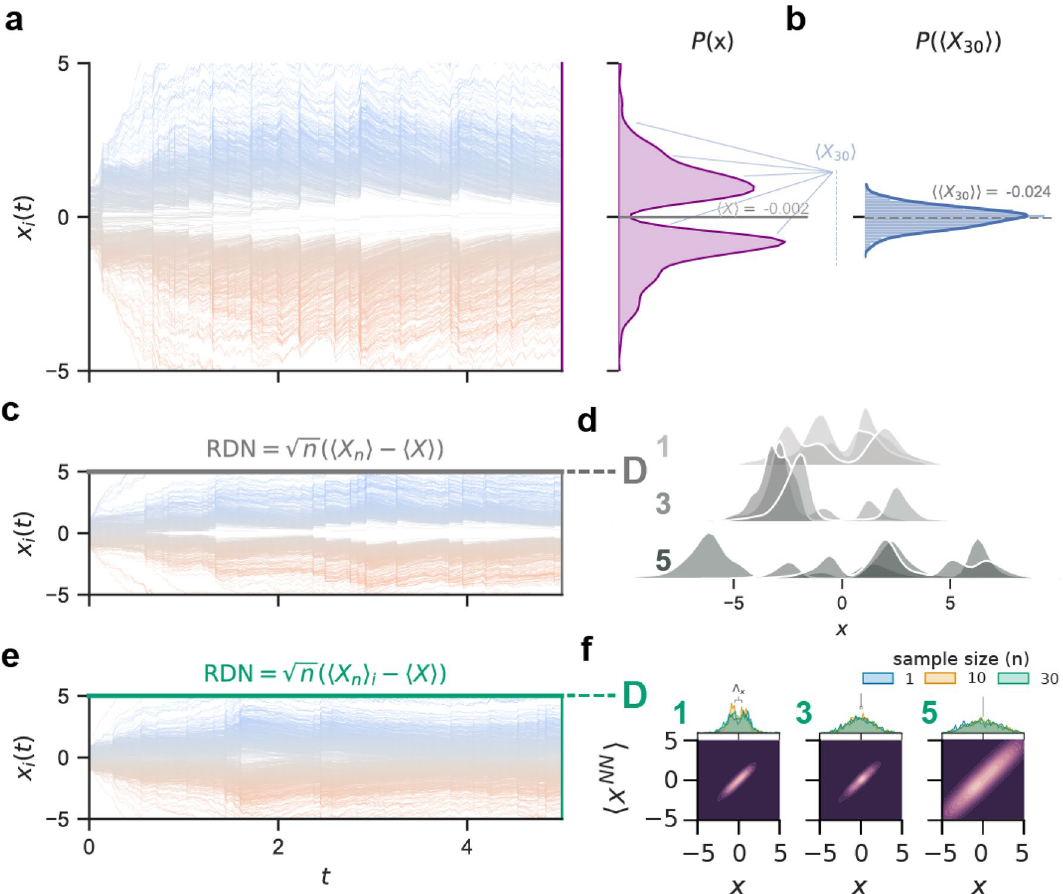
Figure 2. The normalizing effect of a random dynamical nudge based on the central limit theorem. Given a 5 is close to 0. An approximation of this X polarized network of agents ( a ), the mean of the opinions at t = (cid:31) (cid:30) X 30 mean value, using the Central Limit Theorem (CLT), was gathered by sampling 30 opinions (i.e. with (cid:31) (cid:30) 5 and taking the mean of these sample means: X 30 sample size n of 30) a thousand times at t ( b ). Applying = (cid:31)(cid:31) (cid:30)(cid:30) X n the RDN formulated as a CLT term, but where each agent sees the same sample mean , was insufficient to (cid:31) (cid:30) achieve a normal distribution of agent opinions ( c ), regardless of RDN strength D ( d ). Instead, each agent must X n see their own sample mean to prevent a network from becoming polarized ( e ). This was true for different (cid:31) (cid:30) i 0, 1, 3, 5 RDN strengths ( D ). Varying the sample size n did not significantly change distributions. The RDN ∈ { } causes the opinions to be predominantly neutral